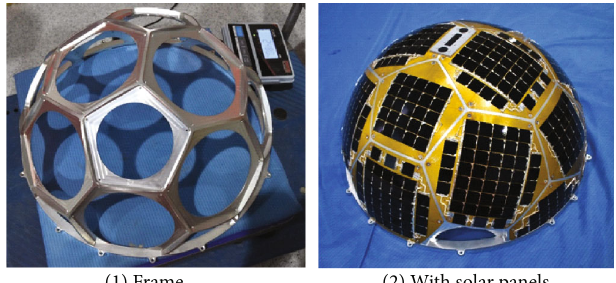
Figure 5: The hemisphere.